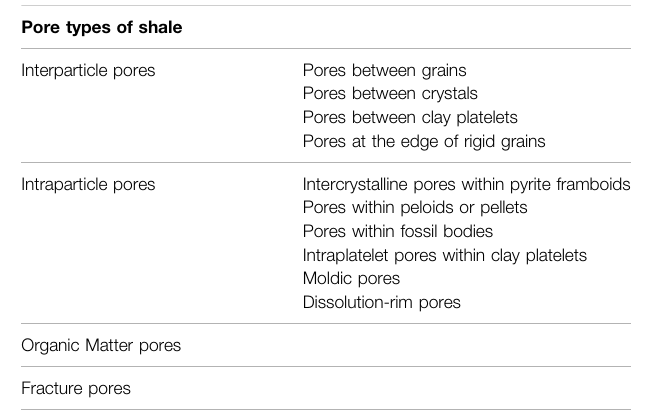
TABLE 1 | The type of shale pores (Loucks et al., 2012).